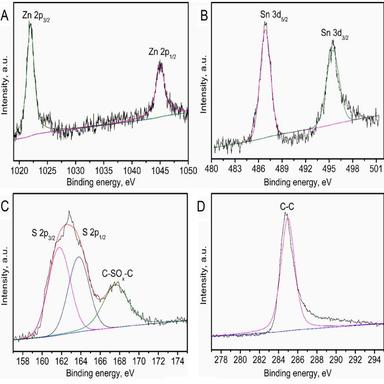
High resolution XPS spectra of ZnS-SnS@C/EG composite. (A) Zn 2p; (B) Sn 3d ; (C) S 2p; (D) C 1s.